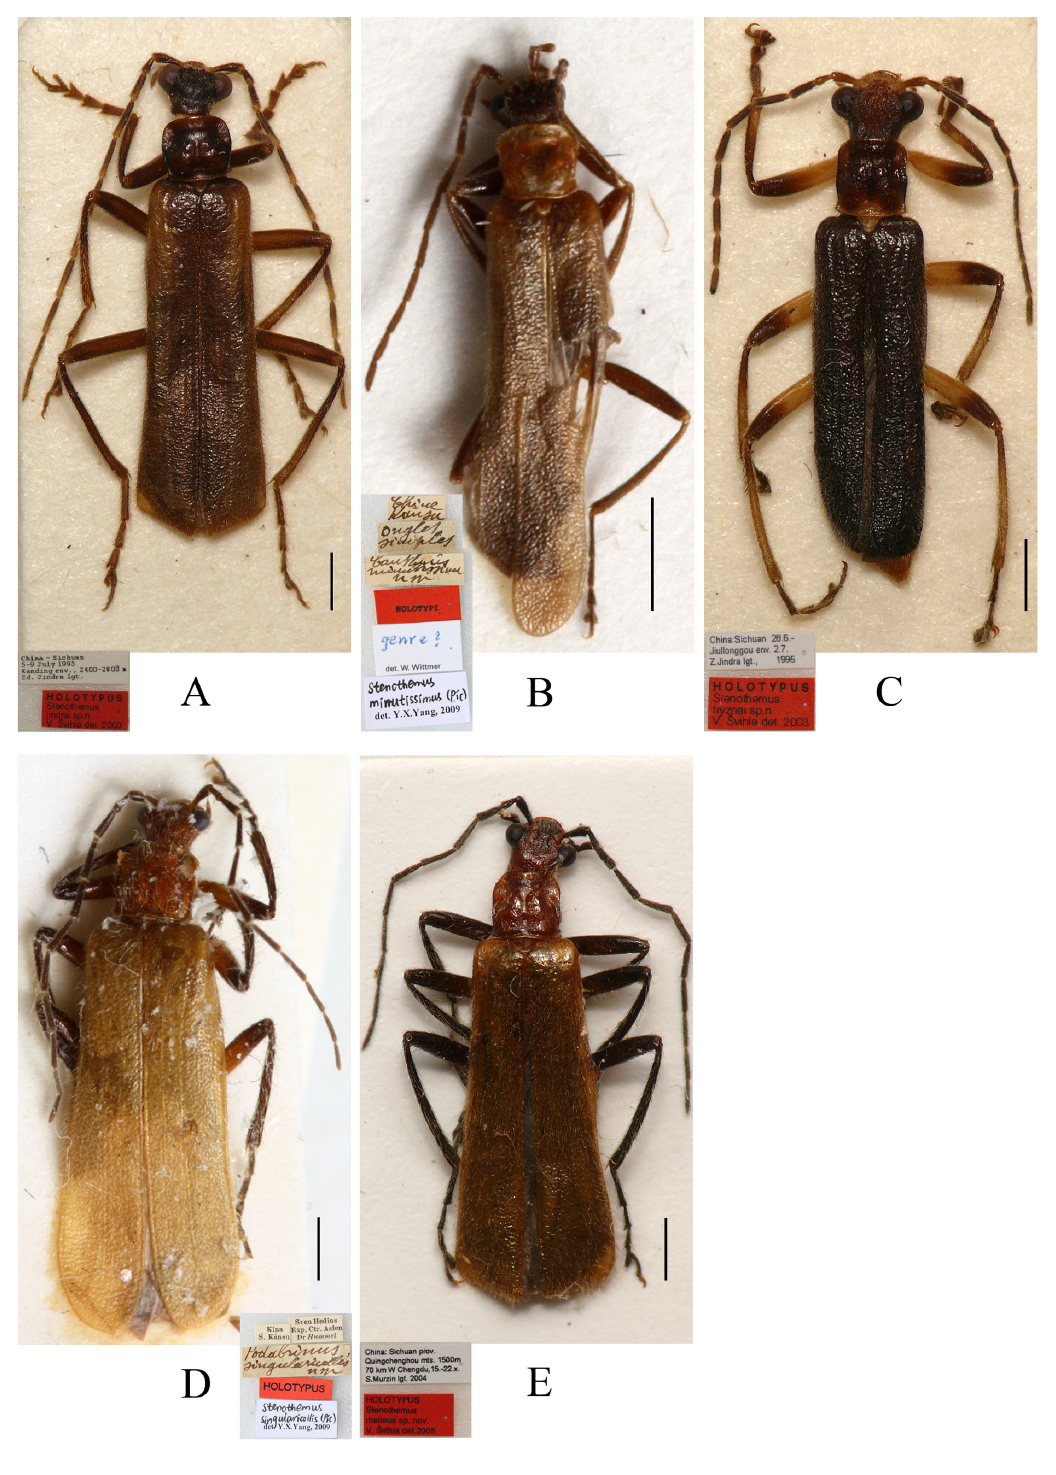
Fig. 5. Habitus, dorsal view. A . Stenothemus jindrai Švihla, 2004, holotype, ♂ (NMPC). B . S . minutissimus (Pic, 1933) comb. nov., holotype, ♂ (MNHN). C . S . tryznai Švihla, 2004, holotype, ♂ (NMPC). D . S . singularicollis (Pic, 1933) comb. nov., holotype, ♀ (NHMH). E . S . melleus Švihla, 2005 syn. nov., holotype, ♂ (= S. singularicollis ) (NMPC). Scale bars = 1.0